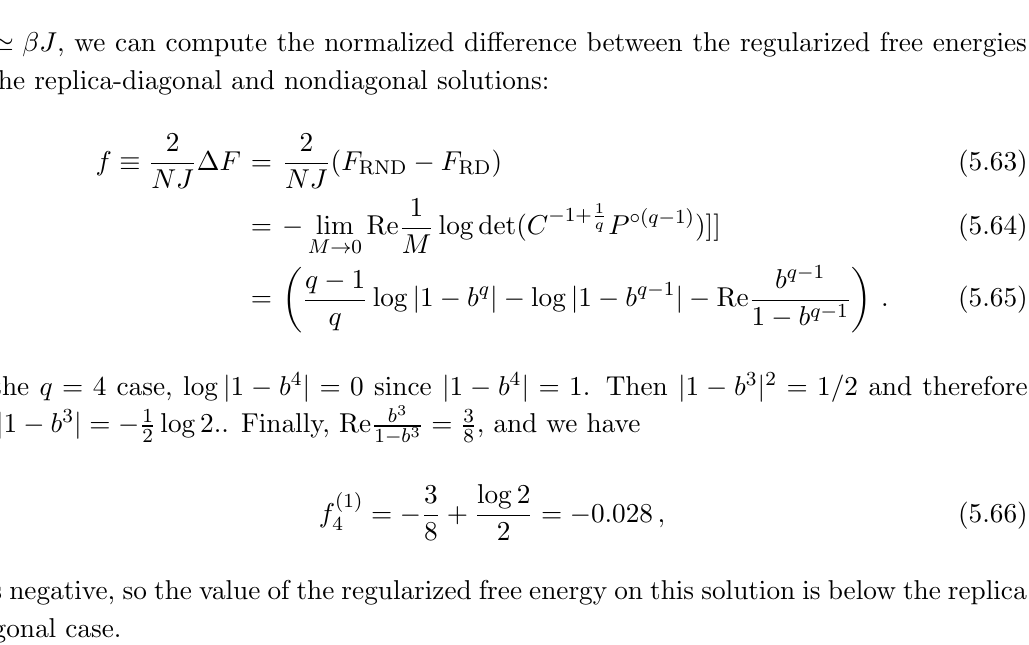
Figure 5 . (a) Locations of the dominant root of (5.60) for q = 4 ; 6 ; : : : 20 (14,16,18,20 | green). (b) Absolute value of the dominant root of (5.60) for q = 4 ; 6 ; : : :